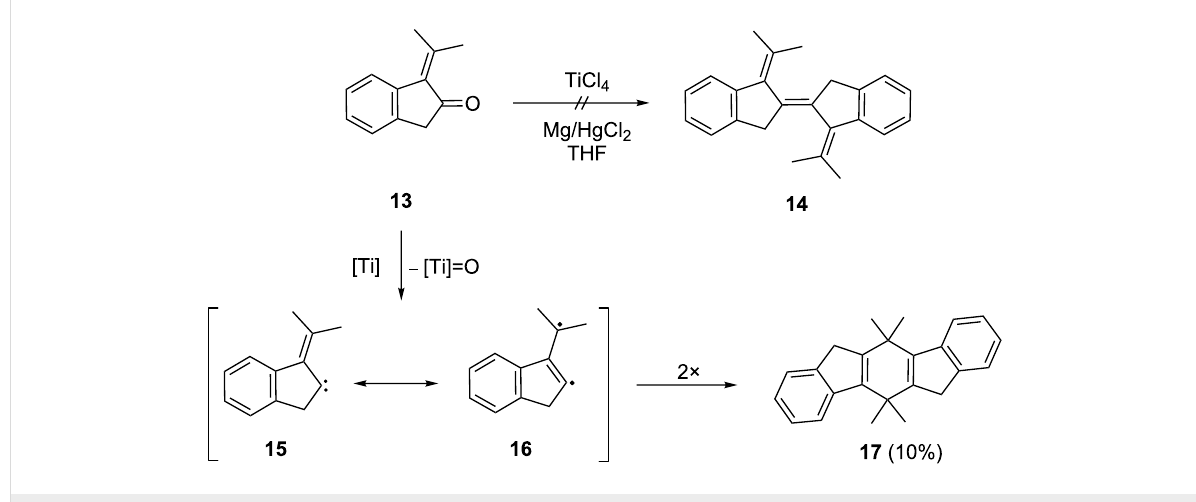
Scheme 3: Dimerization of 13 under McMurry conditions.